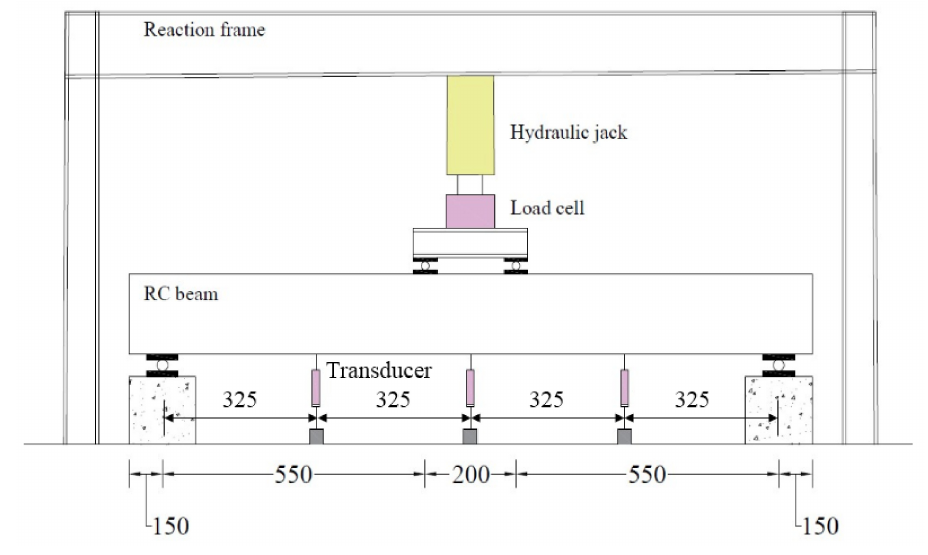
Figure 10. Typical loading setup (all dimensions in mm).